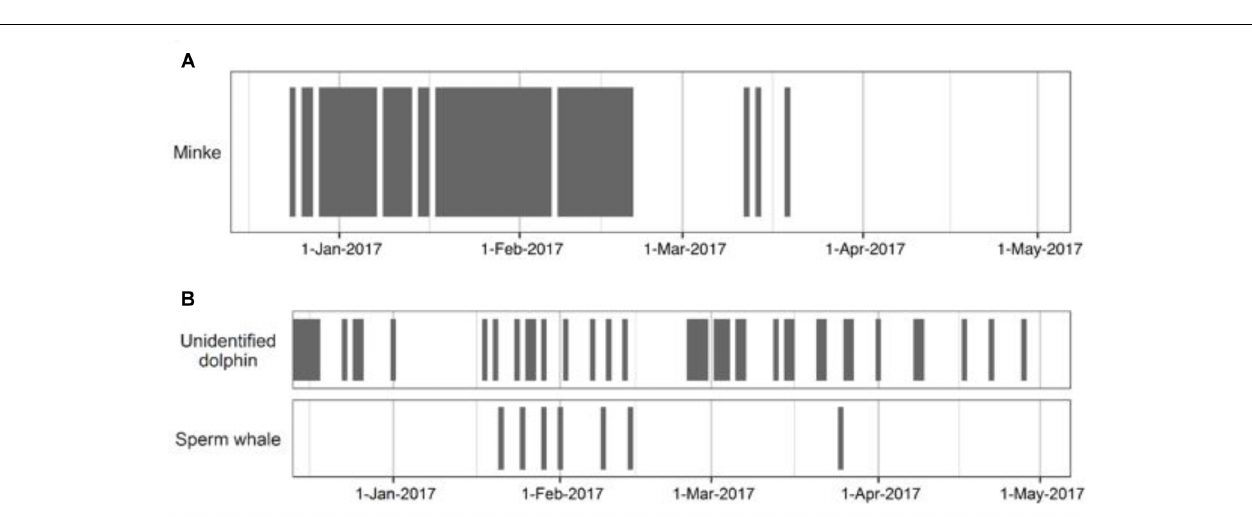
FIGURE 3 | Daily presence of (A) minke whale pulse trains in Martinique and (B) unidentified dolphin whistles and sperm whale clicks and social sounds in